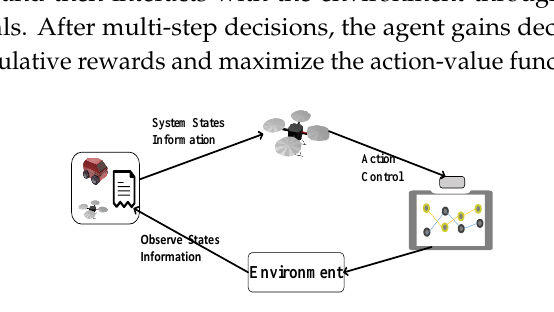
Figure 5. At each step, the UAV observes the environment and interacts with it through actions while receiving immediate signals and updating information of the environment. After multi-step decisions, the UAV acquires decision-making experience and then optimizes the entire task sequence.